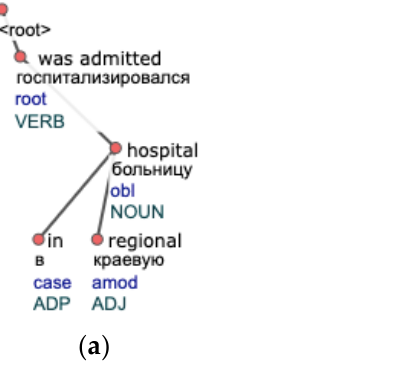
Figure 5. Tree examples of sentences that form a repeat by our algorithm: ( a ) A tree of a sentence about a patient’s hospitalization; ( b ) Another tree with similar information about a patient said in other words.